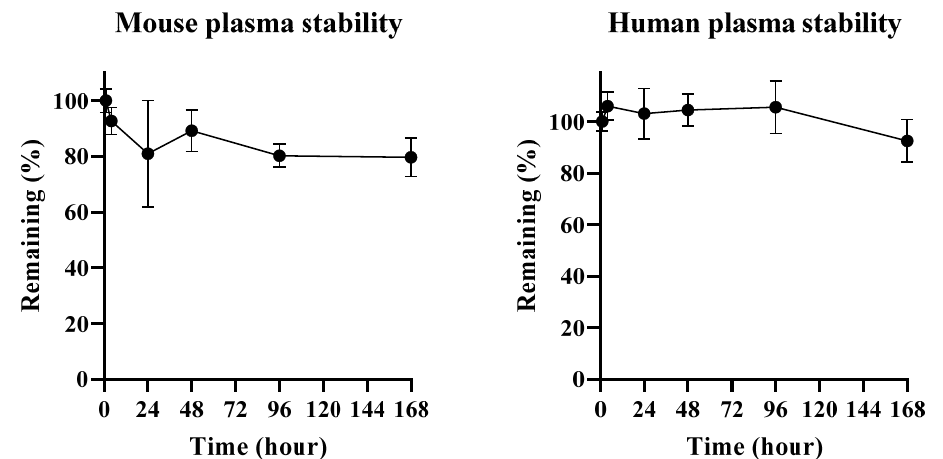
Figure 6. Plasma stability test result of albumin conjugated MAC glucuronide phenol linked SN-38 in mouse and human plasma.